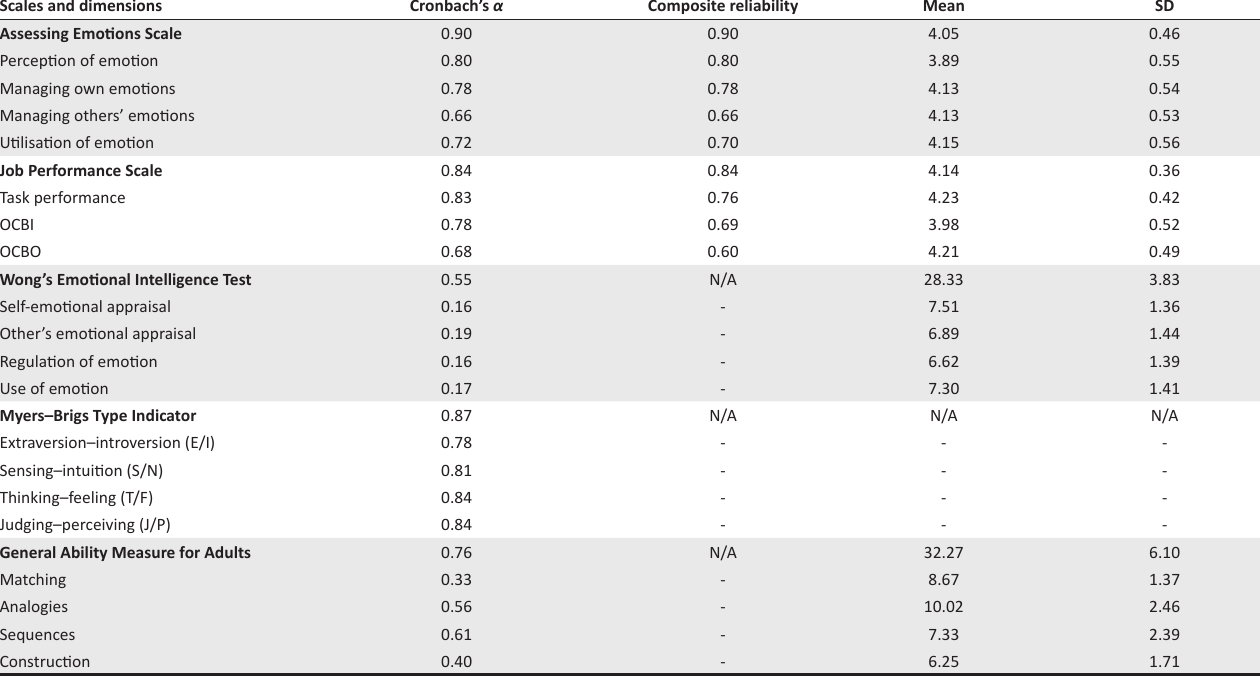
TABLE 3: Descriptive statistics and internal consistency